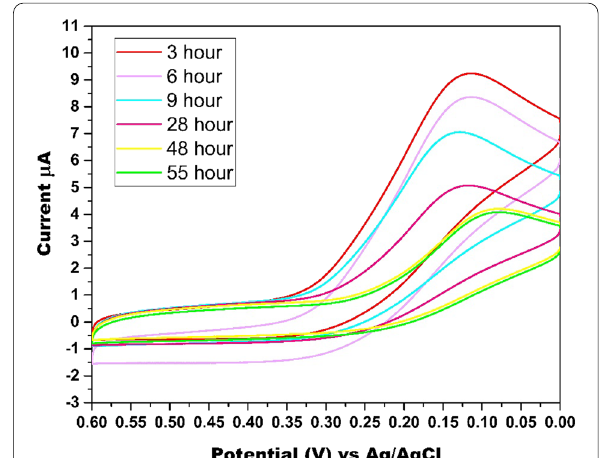
Fig. 5 Cyclic voltammogram at different time intervals of 60 mg